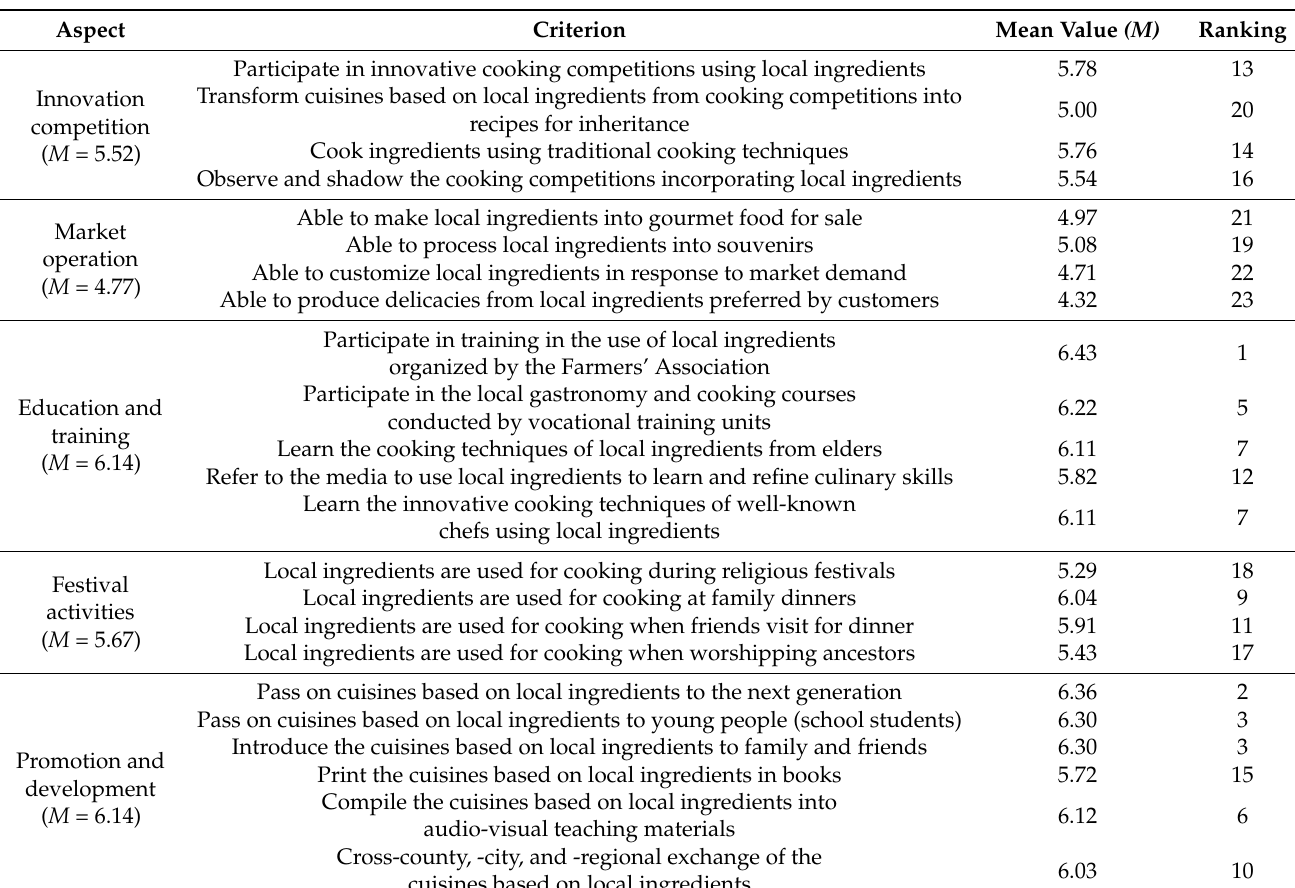
Table 5. Indicator confirmation analysis table for the sustainable inheritance of rural cooking techniques and innovative business